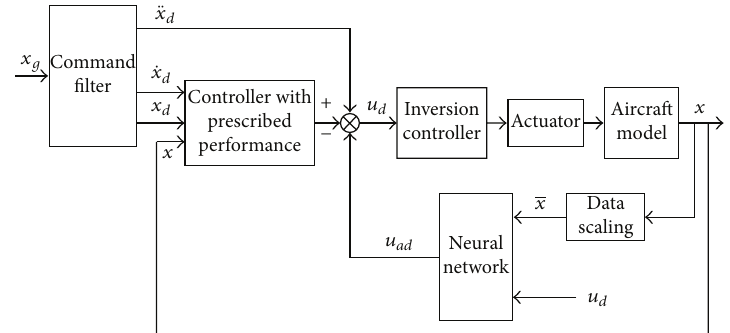
Figure 1: Adaptive neural network dynamic inversion with prescribed performance